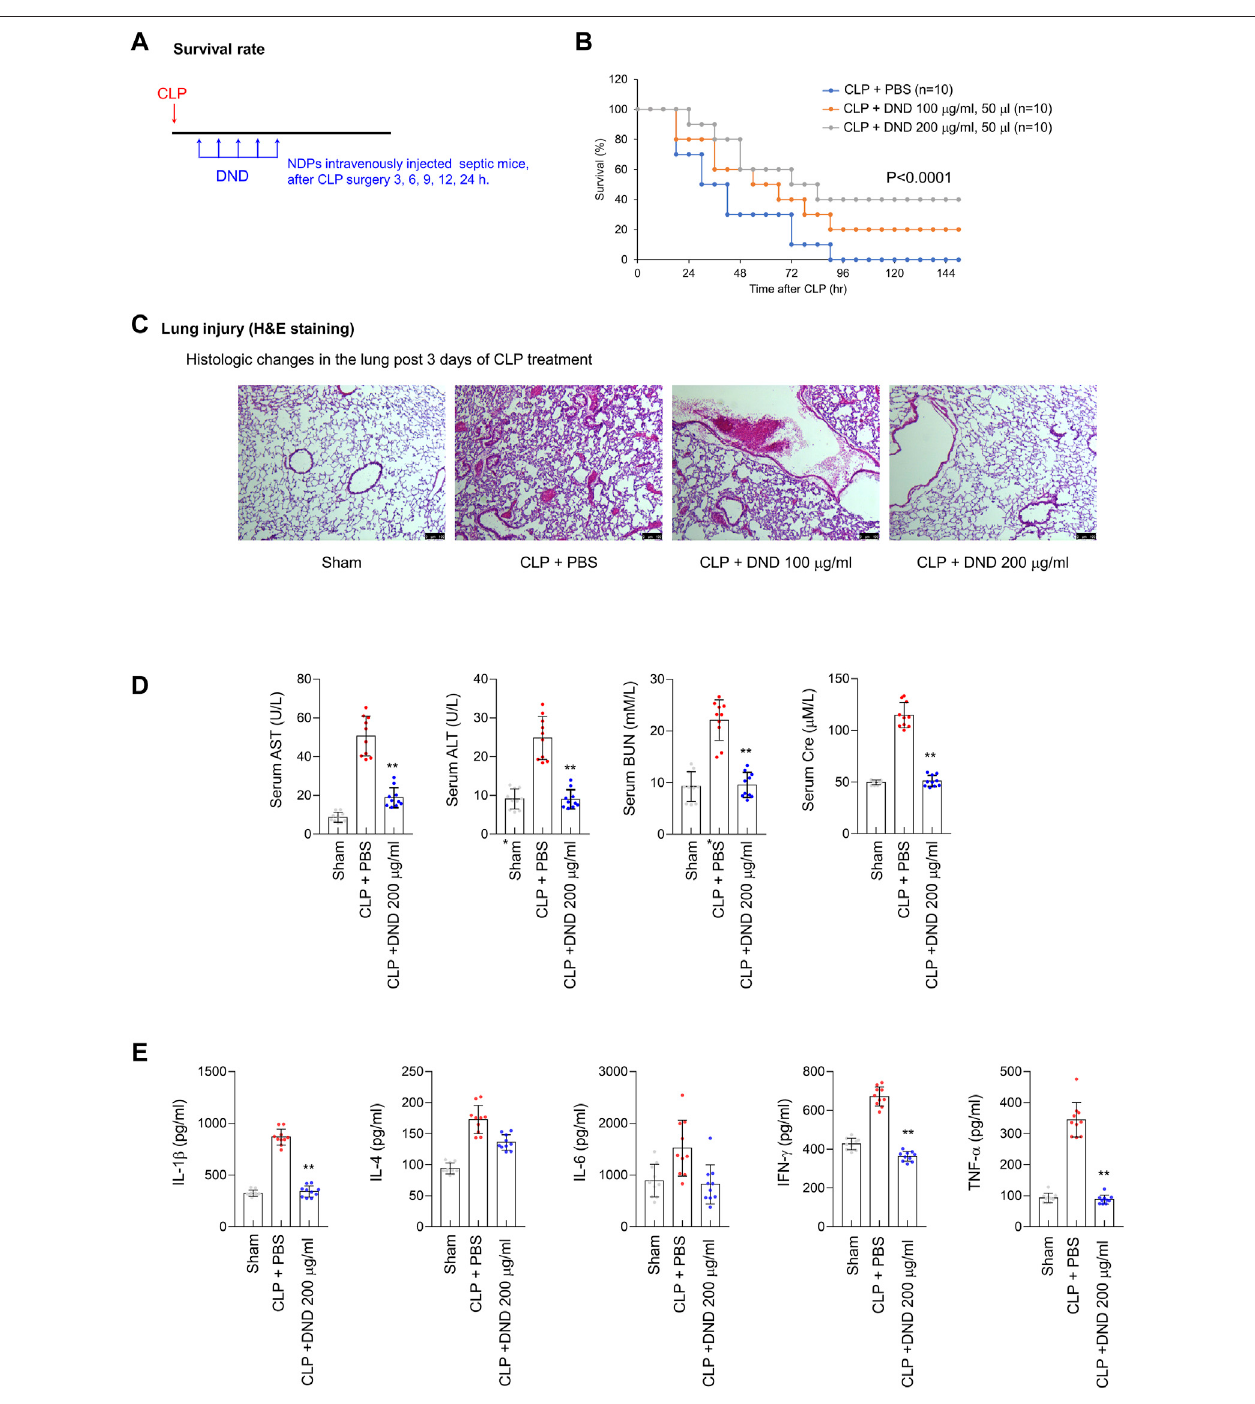
FIGURE 5 | The preventive effect of DND for the CRS condition from a CLP mouse model. (A) The timeline of in vivo experiments using CLP-operated mice. (B) SurvivalrateofCLPmiceaftertheintravenousadministrationofDND( n =10pergroup). (C) HistologicalanalysisofCLPlungtissuesaftertheadministrationofDND( n =5 per group). (D) Serum level of tissue damage markers including aspartate aminotransferase (AST), alanine aminotransferase (ALT), blood urea nitrogen (BUN), and creatinine in mice (** p < 0.01, n = 10). (E) Serum levels of in fl ammatory cytokines including IL-1 β , IL-4, IL-6, IFN- γ , and TNF- α (* p < 0.05 and ** p < 0.01, n = 10).